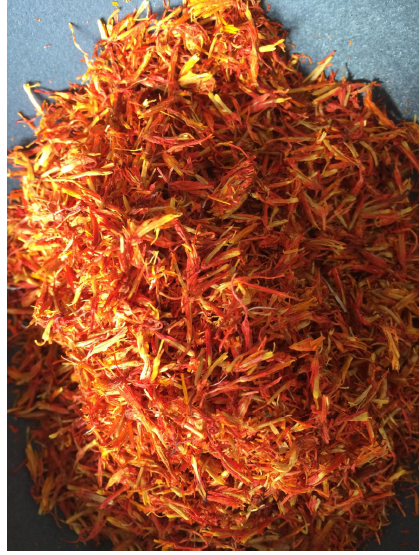
Figure 7 Figure 7. Sa ffl ower petals. Photograph: Sylvia Houghteling.